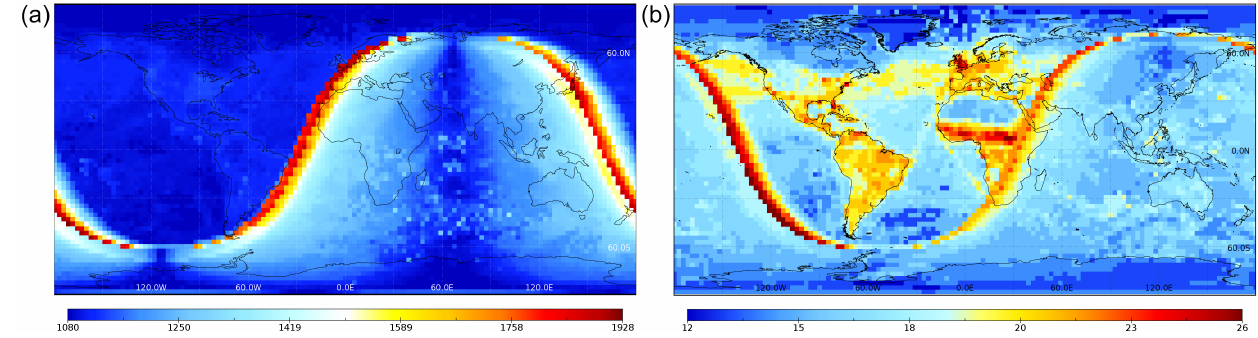
Figure 1. Number of integration steps for column MECCA kernel execution (a) and intra-column maximum difference in execution steps (b) . The adaptive time-step integrator shows a non-uniform runtime caused by stratospheric photochemistry and natural and anthropogenic